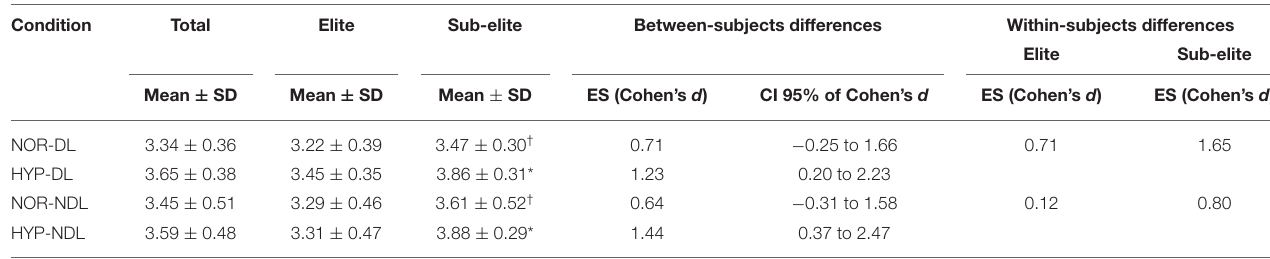
TABLE 2 | Balance index scores for the high and low playing level groups in NOR and HYP condition.